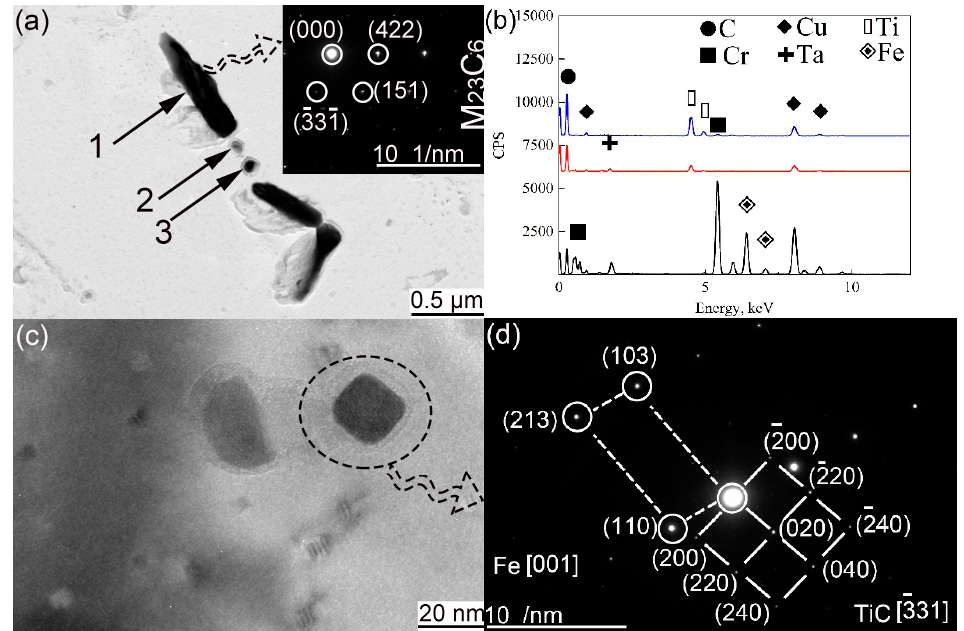
Figure 12. Secondary phases in the MX steel: ( a ) carbides and the selected area electron diffraction (SAED) pattern of particle 1; ( b ) EDS results of the carbides marked in ( a ); ( c ) particles distributed in a small grain (several hundred nanometers); ( d ) SAED pattern of the marked area in ( c ).